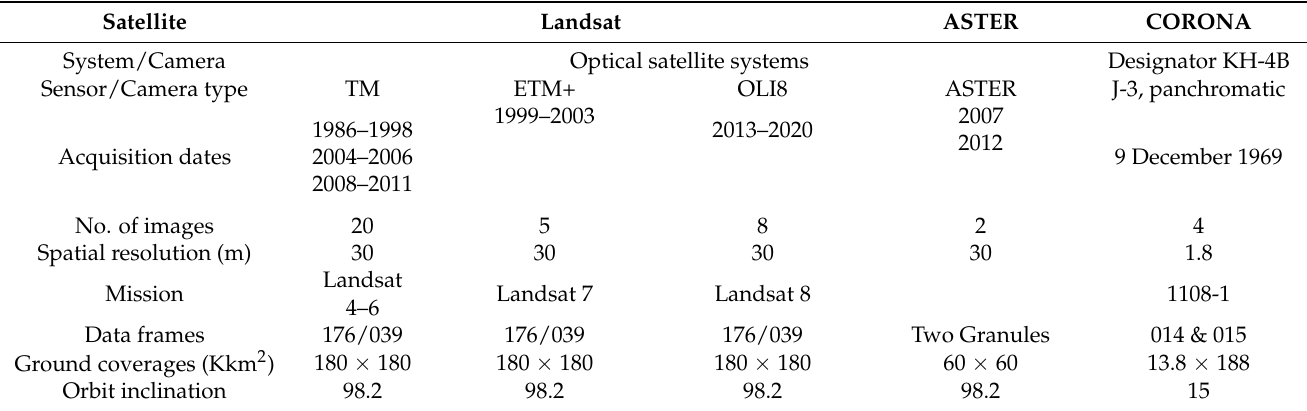
Table 1. Technical specifications of remote sensing imagery used in this